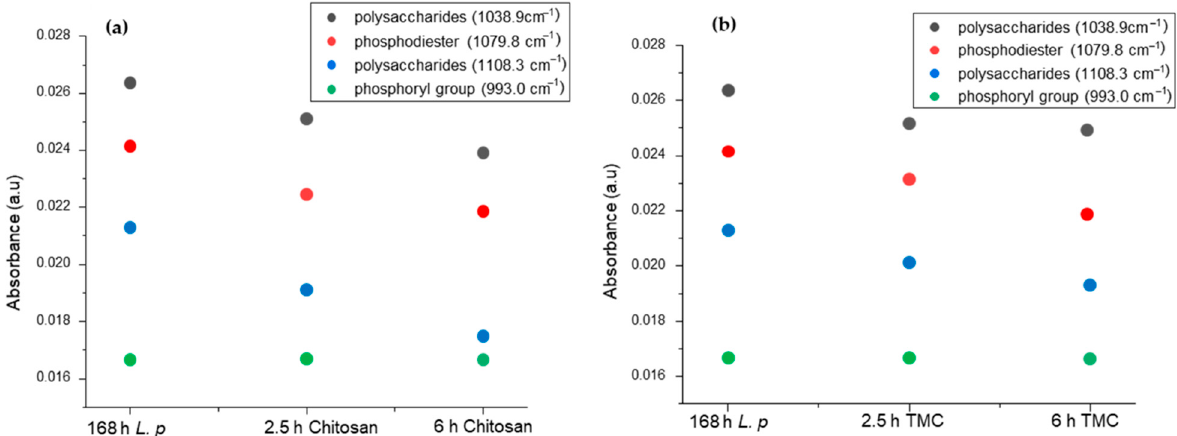
Figure 6. Calculated values between 1150–950 cm − 1 for the band of polysaccharides (1038 cm − 1 , black, left), polysaccharides (1108.3 cm − 1 , blue, left), phosphodiesters (1079.8 cm − 1 , red, left), and phosphoryl group (993.0 cm − 1 , green, left), from the cumulative impulse fit of the IR spectra monitored after 168 h of L. parabuchneri incubation in MRS media and after 2.5 h and 6 h of ( a ) chitosan and ( b ) TMC insertion.